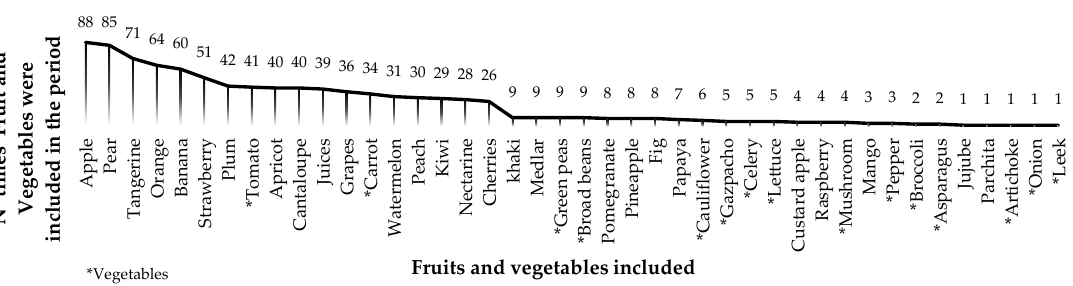
Figure 2. Frequency and kinds of fruits and vegetables included in the School Fruit and Vegetables Scheme in Spain (2009–2017).